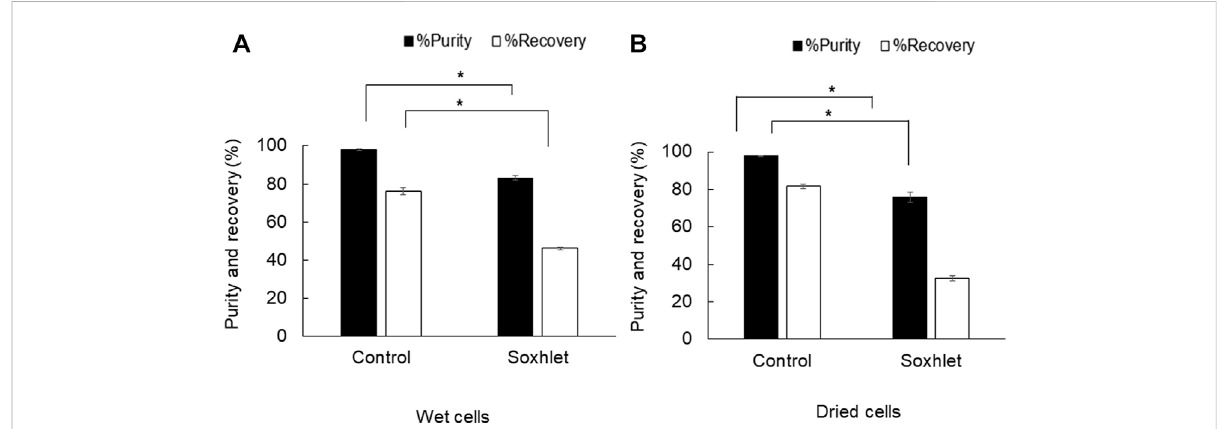
FIGURE 2 Ef fi ciency of PHB extraction using a Soxhlet extractor with 1,3-dioxolane (A) from wet cells and (B) from dried cells. All the data are representative of the results of three independent experiments and are expressed as the mean values ± standard deviations (SDs). The asterisk indicates a signi fi cant difference ( p < 0.05).